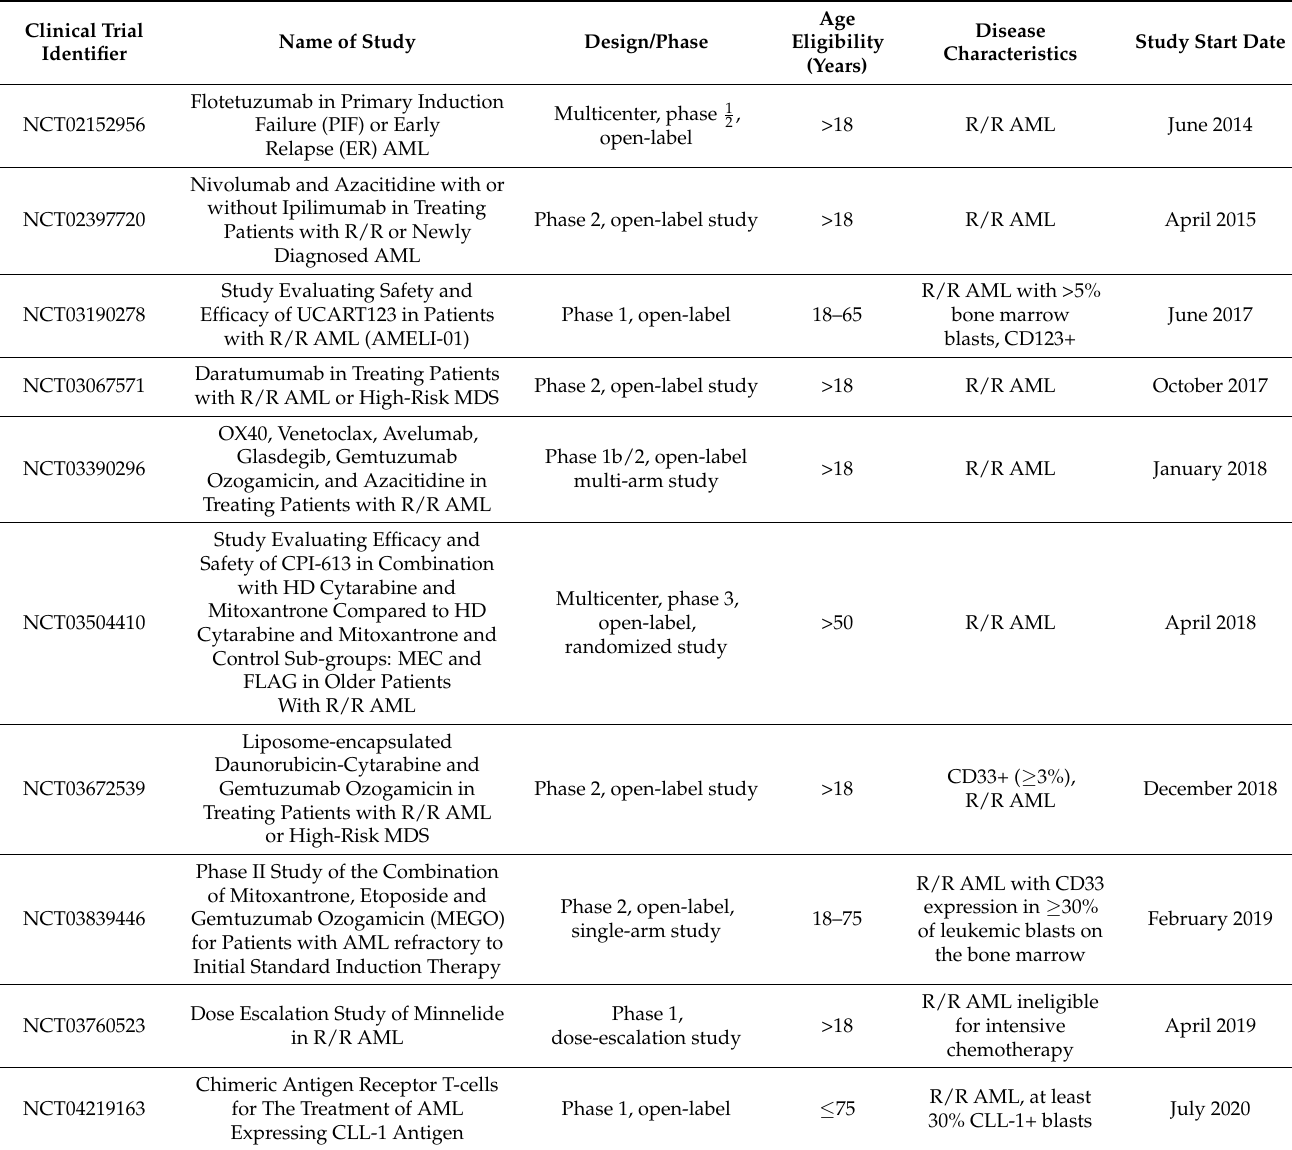
Table 4. List of ongoing clinical trials including patients with newly diagnosed or relapsed/refractory intermediate-risk AML in the United